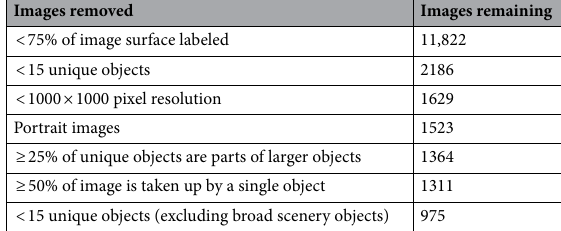
Table 1. Steps taken to filter through the LabelMe database. List of filters applied, and number of images remaining after filtering, that lead to the unbiased selection of 100 experimental images.